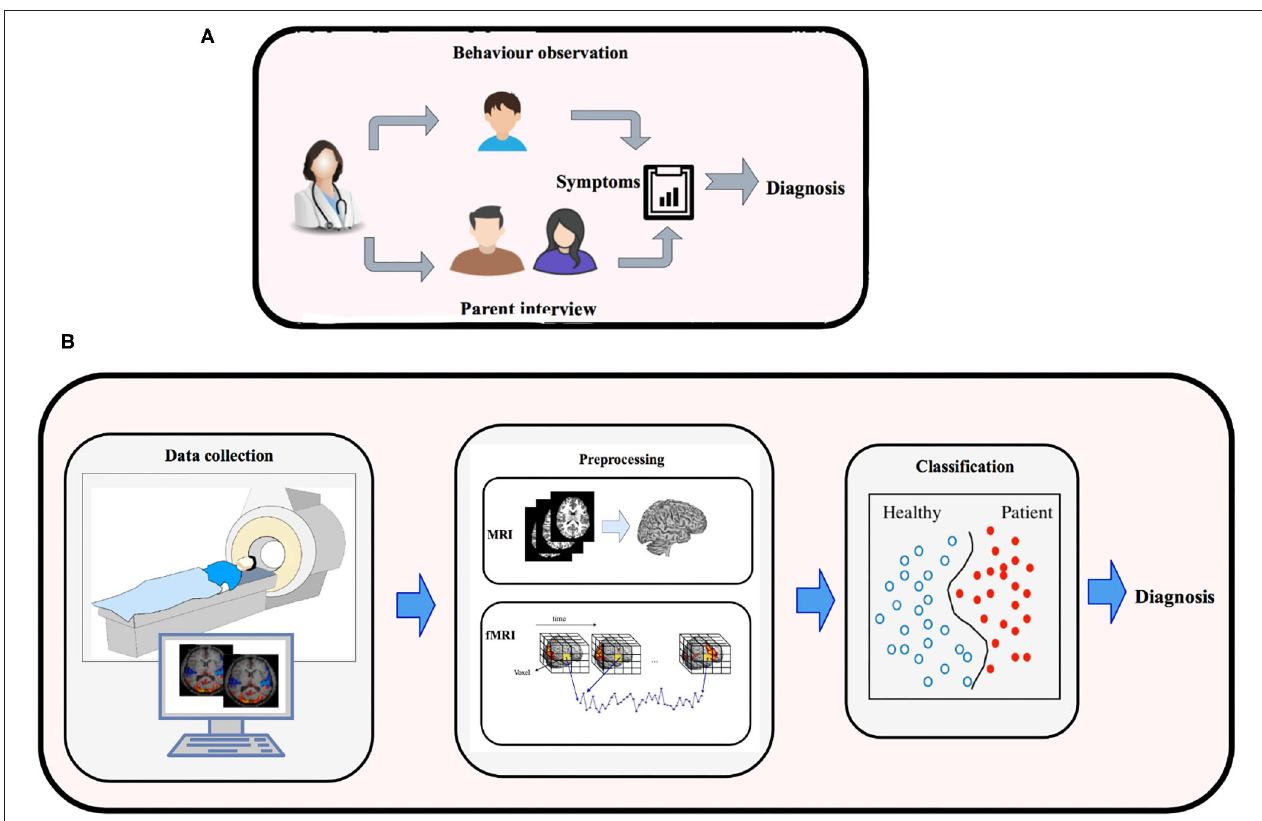
FIGURE 1 | (A) Traditional methods for diagnosing brain disorders vs. (B) classification based on brain imaging and machine